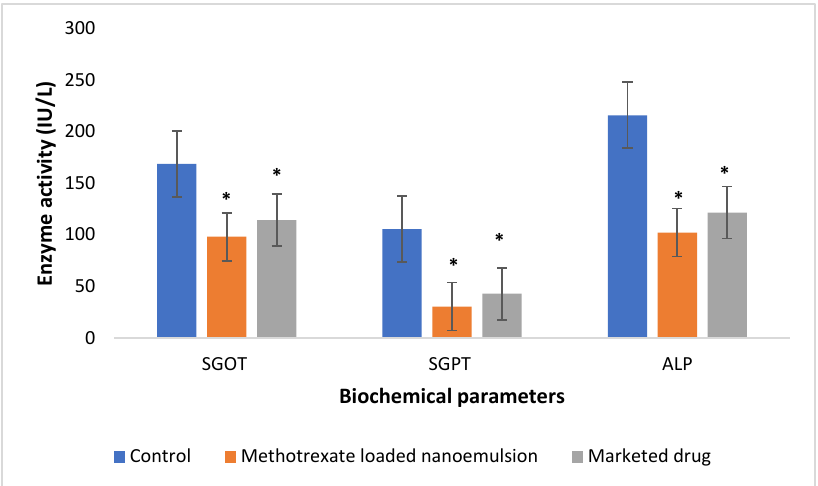
Figure 12. Liver-function tests for methotrexate-loaded nanoemulsion and pure methotrexate solution. Results are shown as mean ± SEM ( n = 6) and analyzed by one-way ANOVA followed by Tukey’s test; * p < 0.05 significance difference compared to control group.